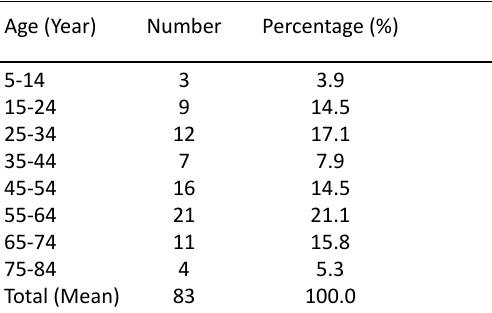
Table 2. Percentage and numbers of infected patients, according to the